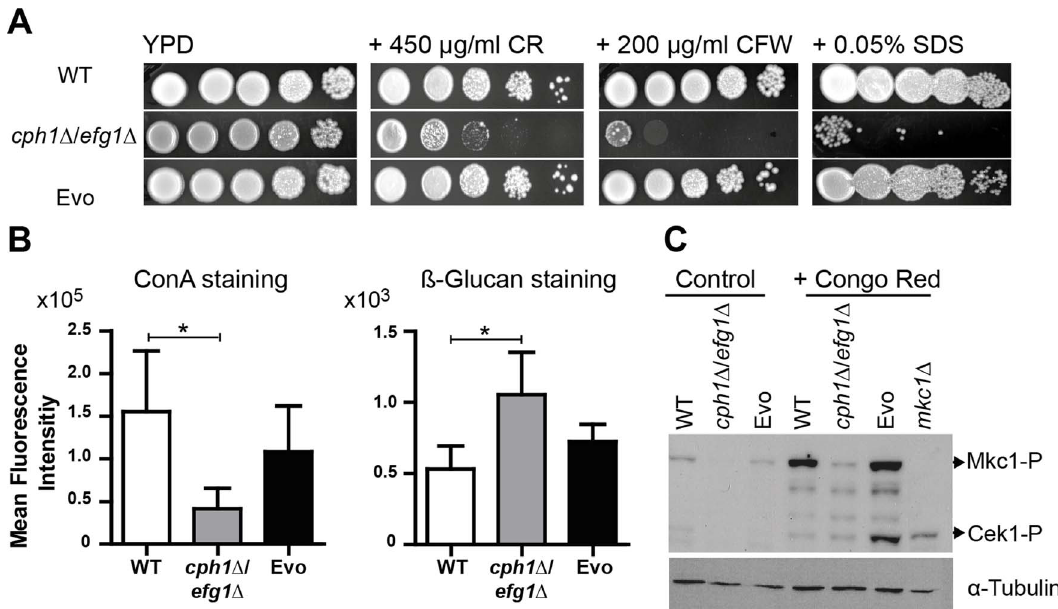
Fig. 5. Microevolution led to decreased sensitivity of the Evo strain to different cell wall perturbing agents. ( A ) Resistance of analyzed strains against different cell wall stressors. The cph1 D / efg1 D strain was sensitive to all stresses while the Evo strain regained WT resistance (representative pictures of three experiments are shown). ( B ) Flow cytometry analysis of mannan and b -glucan exposure on the surface of live cells. Differences in fluorescence intensity between cph1 D / efg1 D strain and Evo strain point to an altered cell wall composition. Mean fluorescence intensity + SD of n=3 (*p , 0.05). ( C ) Western blot analysis to identify phosphorylated Mkc1 and Cek1 in C. albicans strains grown under non-stress conditions (control) or conditions of cell wall stress (450 m g/ml congo red) for 4 hours. Cell wall stress triggered phosphorylation of Mkc1 and Cek1 in the Evo strain, but not in the cph1 D / efg1 D strain. Tubulin served as loading control.